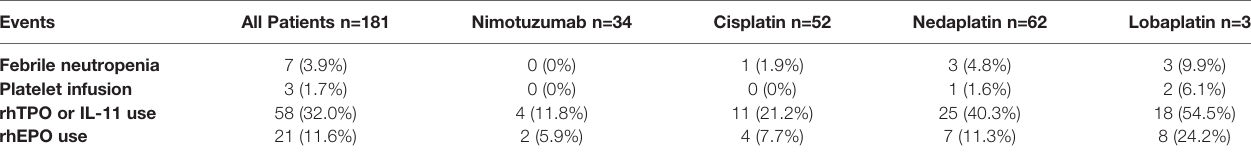
TABLE 4 | Febrile neutropenia, platelet infusion and requirement of growth factors during concurrent chemoradiotherapy in LAHNC patients. Events